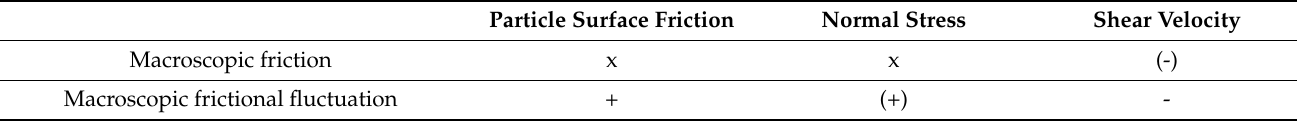
Table 3. Conclusions in the breccia